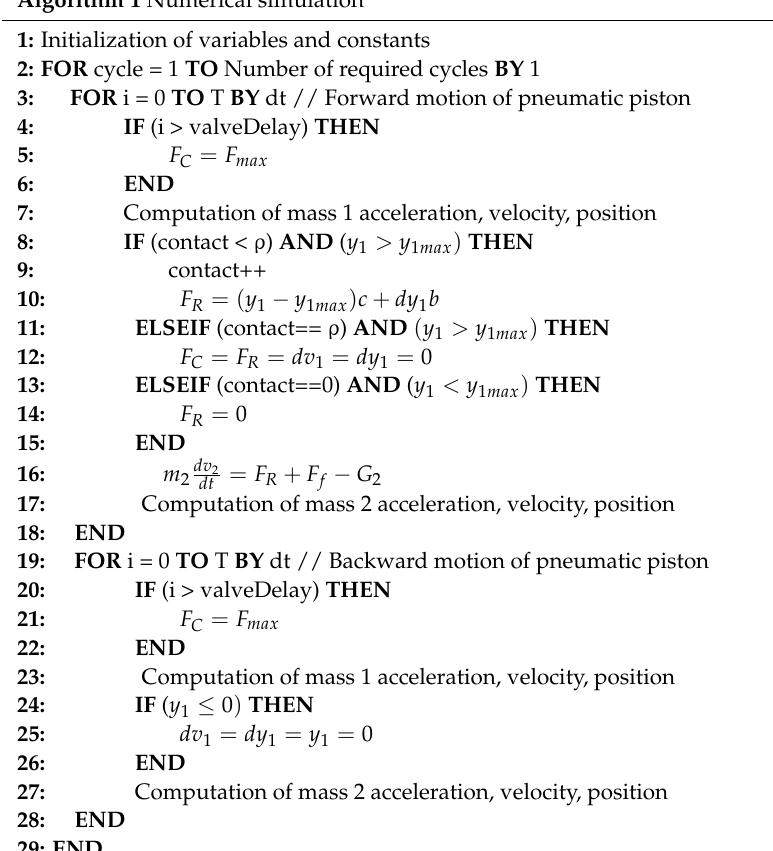
Algorithm 1 Numerical